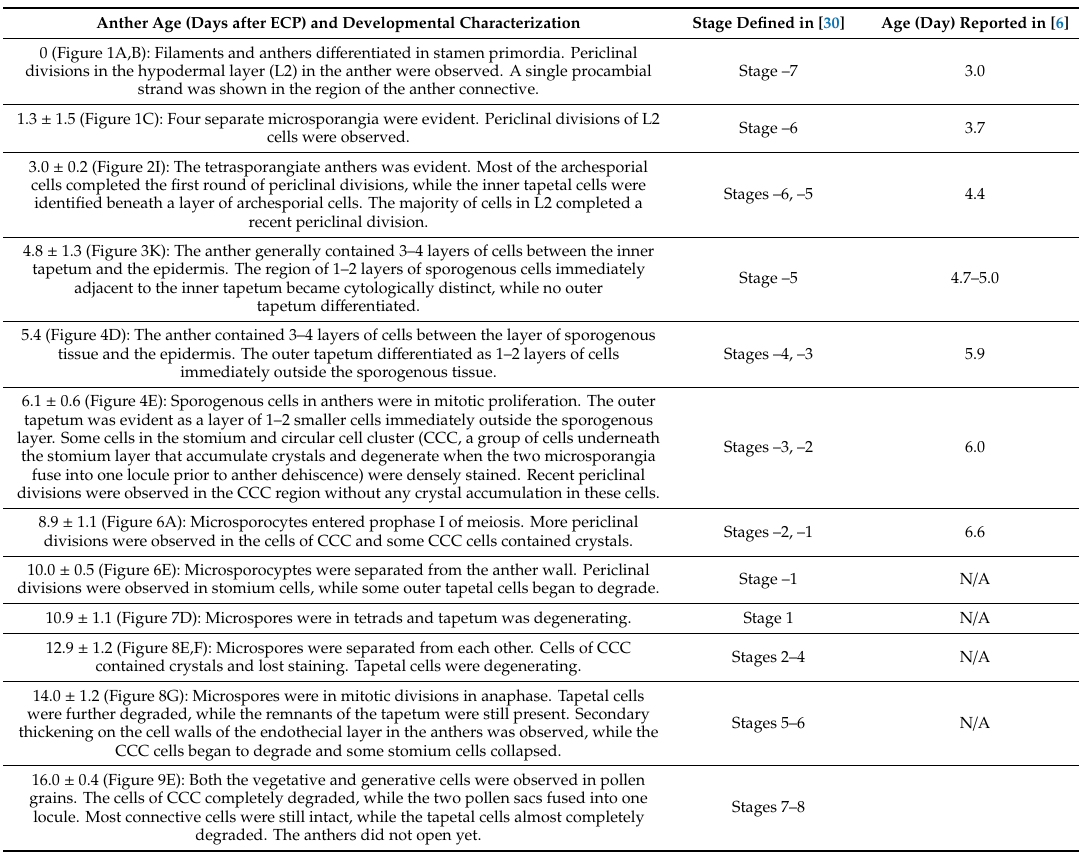
0 (Figure 1A,B): Filaments and anthers di ff erentiated in stamen primordia. Periclinal divisions in the hypodermal layer (L2) in the anther were observed. A single procambial strand was shown in the region of the anther